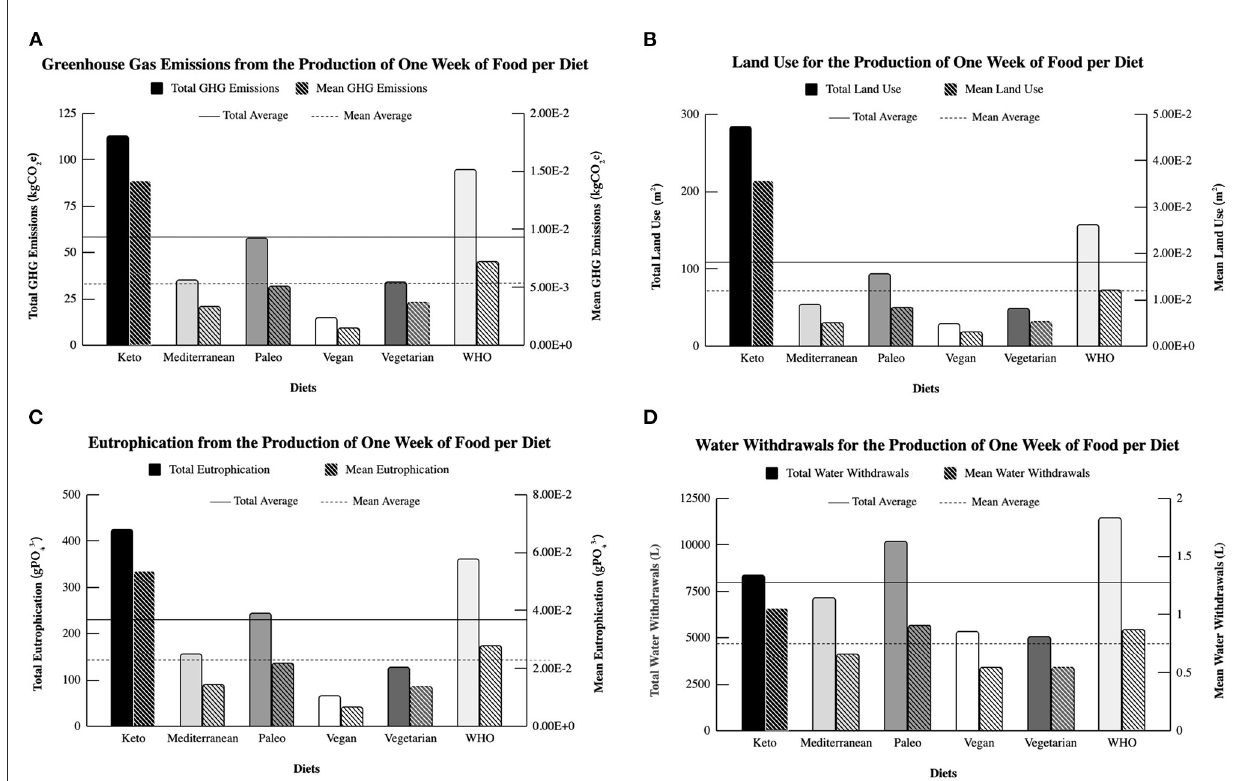
FIGURE1 (A) Greenhouse gas emissions (GHG, in kilograms of carbon dioxide equivalents) calculated for each diet from a week of meals at 2,000 kilocalories/day. Total GHG emissions (left Y-axis) are calculated by summing the emissions of all food items within a diet, adjusted to each food’s quantity in grams. The accompanying solid line shows the average of total emissions across all diets. Mean GHG emissions (right Y-axis) are calculated by dividing a diet’s total GHG emissions by the quantity of food grams within that diet, resulting in a mean value. The accompanying dashed line shows the average of mean emissions across all diets. (B) Land use (in square meters) calculated for each diet from a week of meals at 2,000 kilocalories/day. Total land use (left Y-axis) is calculated by summing the land use of all food items within a diet, adjusted to each food’s quantity in grams. The accompanying solid line shows the average of total land use across all diets. Mean land use (right Y-axis) is calculated by dividing a diet’s total land use by the quantity of food grams within that diet, resulting in a mean value. The accompanying dashed line shows the average of mean land use across all diets. (C) Eutrophication (in grams of phosphate) calculated for each diet from a week of meals at 2,000 kilocalories/day. Total eutrophication (left Y-axis) is calculated by summing the eutrophication of all food items within a diet, adjusted to each food’s quantity in grams. The accompanying solid line shows the average of total eutrophication across all diets. Mean eutrophication (right Y-axis) is calculated by dividing a diet’s total eutrophication by the quantity of food grams within that diet, resulting in a mean value. The accompanying dashed line shows the average of mean eutrophication across all diets. (D) Water withdrawals (in liters) calculated for each diet for 1 week of meals at 2,000 kilocalories/day. Total water withdrawals (left Y-axis) are calculated by summing the water withdrawals of all food items within a diet, adjusted to each food’s quantity in grams. The accompanying solid line shows the average of total water withdrawals across all diets. Mean water withdrawals (right Y-axis) are calculated by dividing a diet’s total water withdrawal by the quantity of food grams within that diet, resulting in a mean value. The accompanying dashed line shows the average of mean water withdrawals across all